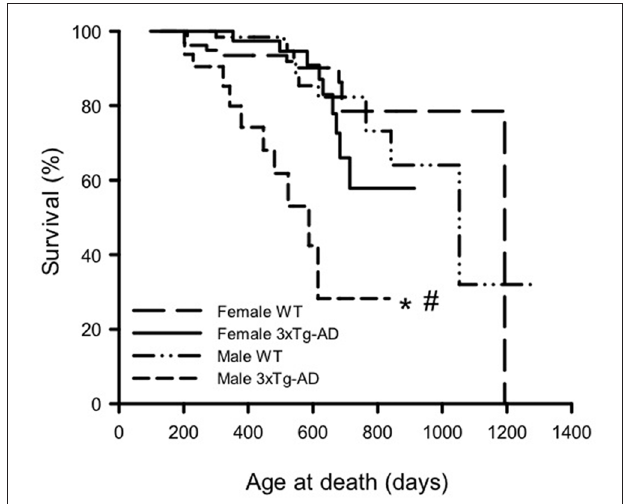
FIGURE 1 | Kaplan-Meier survival curves for male and female 3xTg-AD and wild-type (WT) mice. Log rank analyses were used to compare survival curves ( p < 0.001). Pairwise analyses show that male 3xTG-AD mice ( n = 33) were significantly shorter lived than both male WT mice ( n = 76), and female 3xTG-AD mice ( n = 54; p < 0.001). By contrast, there was no significant difference in survival between the female WT ( n = 84) and 3xTg-AD mice. ∗ p < 0.05 compared to corresponding female group, # p < 0.05 compared to corresponding WT group.